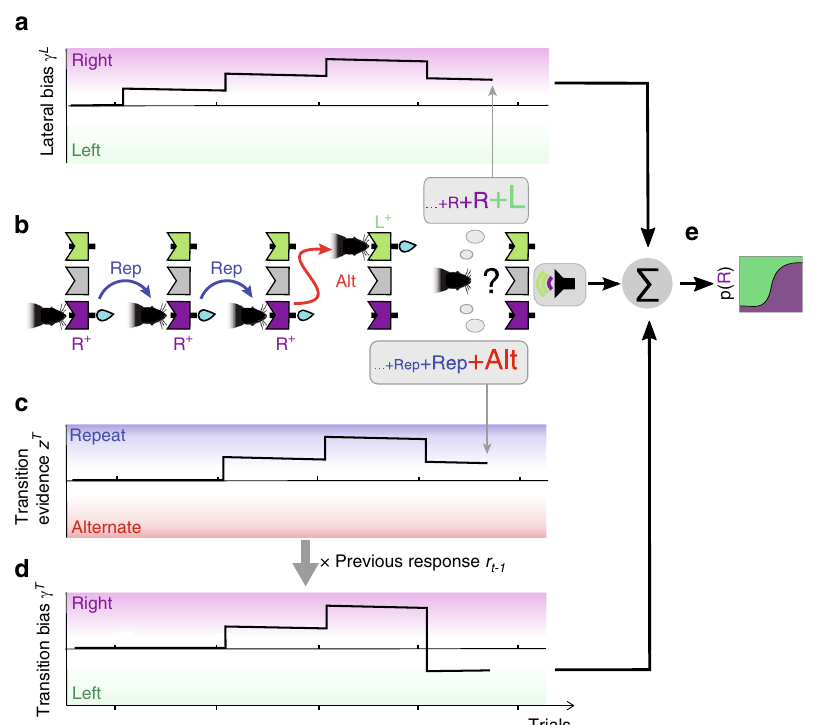
Fig. 3 Dissecting two different history choice biases. Cartoon of an example series of four choices, R + R + R + L + , illustrating the buildup of the lateral and transition biases. a The lateral bias, capturing the tendency to make rightward or leftward responses, increases toward the right in the fi rst three R + trials, and compensates this buildup with the last L + response. Its net impact on the fi nal trial is a rightward bias. b Schematic of the sequence of rewarded responses showing the transitions, de fi ned as the relation between two consecutive responses, being repetitions (Rep, blue arrows) or alternations (Alt, red arrow). The animal computes each choice from combining its expectation based on a weighted sum of previous alternations (bottom gray balloon) and previous responses (upper gray balloon) with the current stimulus sensory information (see last trial). c Transition evidence z T captures the tendency to repeat or alternate the previous response based on the series of previous transitions Rep ++ Rep ++ Alt ++ predicting a repetition in the fi nal trial. d The transition bias γ T is obtained by projecting the transition evidence z T ( c ) onto the right – left choice space via a multiplication with the previous response r t − 1 (see gray arrow). e The evidence provided by the current stimulus is summed to the addition of the biases γ L t + γ T t and passed through a sigmoid function, yielding the probability of selecting a rightward response (Supplementary Fig.